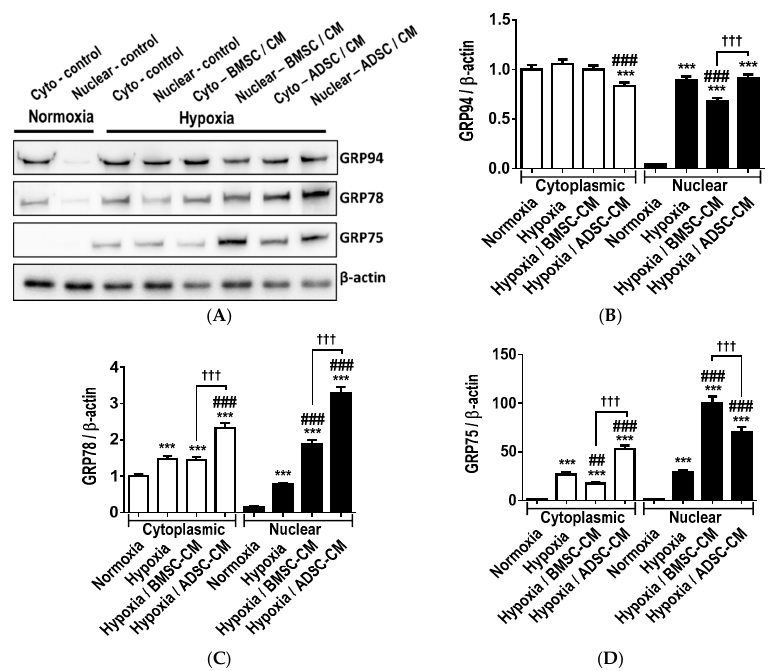
Figure 6. ( A ) Western blot analysis of modulatory effects of human MSC-CM on the expression of GRP intercellular chaperones in primary rat AECs exposed to hypoxia (1.5% O 2 ) for 24 h. Cytoplasmic and nuclear accumulation of ( B ) GRP94, ( C ) GRP78 and ( D ) GRP 75 were quantitated by densitometry and normalized to β -actin. Data presented as mean ± SD; n = 3 (*** p < 0.001 vs. normoxia control; ## p < 0.01, ### p < 0.001 vs. hypoxia control and ††† p < 0.001 vs. hypoxia / BMSC-CM). The resulting data were statistically analysed using one-way ANOVA and Tukey’s multiple comparison